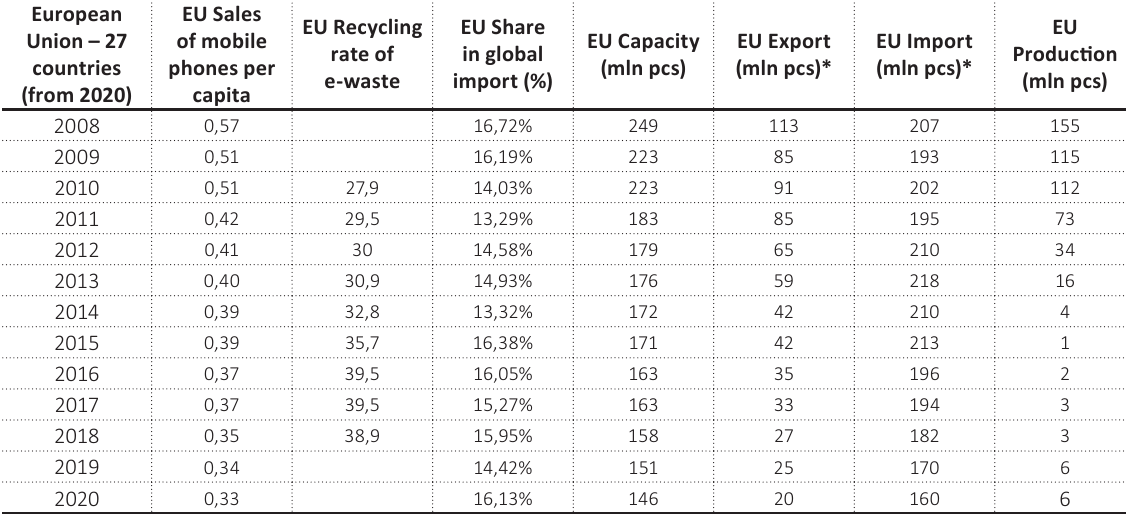
Table A1. Key indices of the development of the mobile phone market in the EU Source: Calculated by the authors based on the Eurostat and UN Comtrade Database data.